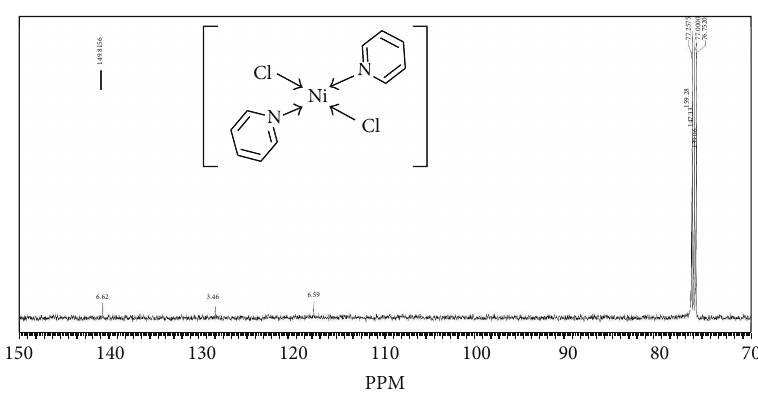
Figure 7: 13 C-NMR spectrum of trans -[Ni(C 5 H 5 N) 2